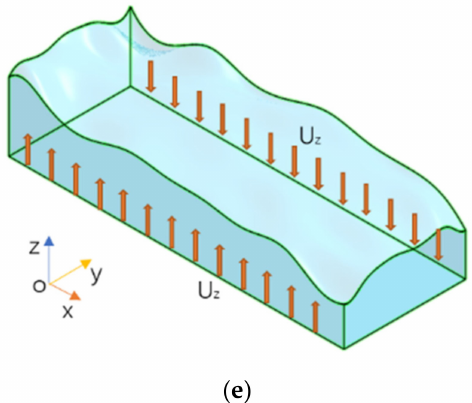
Figure 2. Different stress states. ( a ) Applying gravity stress; ( b ) Applying horizontal squeezing stress in the X direction; ( c ) Applying horizontal squeezing stress in the Y direction; ( d ) Applying shear stress in the XOY coordinate plane; ( e ) Applying shear stress in XOZ coordinate